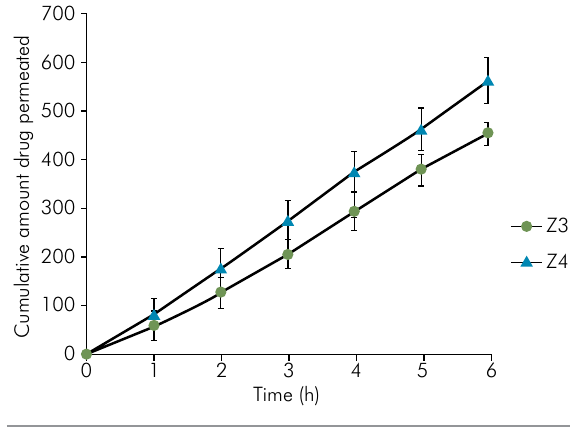
Figure 3. Comparison of ex vivo permeation profile of zolpidem from selected buccal films (Z3 and Z4) using rabbit buccal mucosa over 6 h in a Franz diffusion cell. Values represent the mean of six trials ± standard